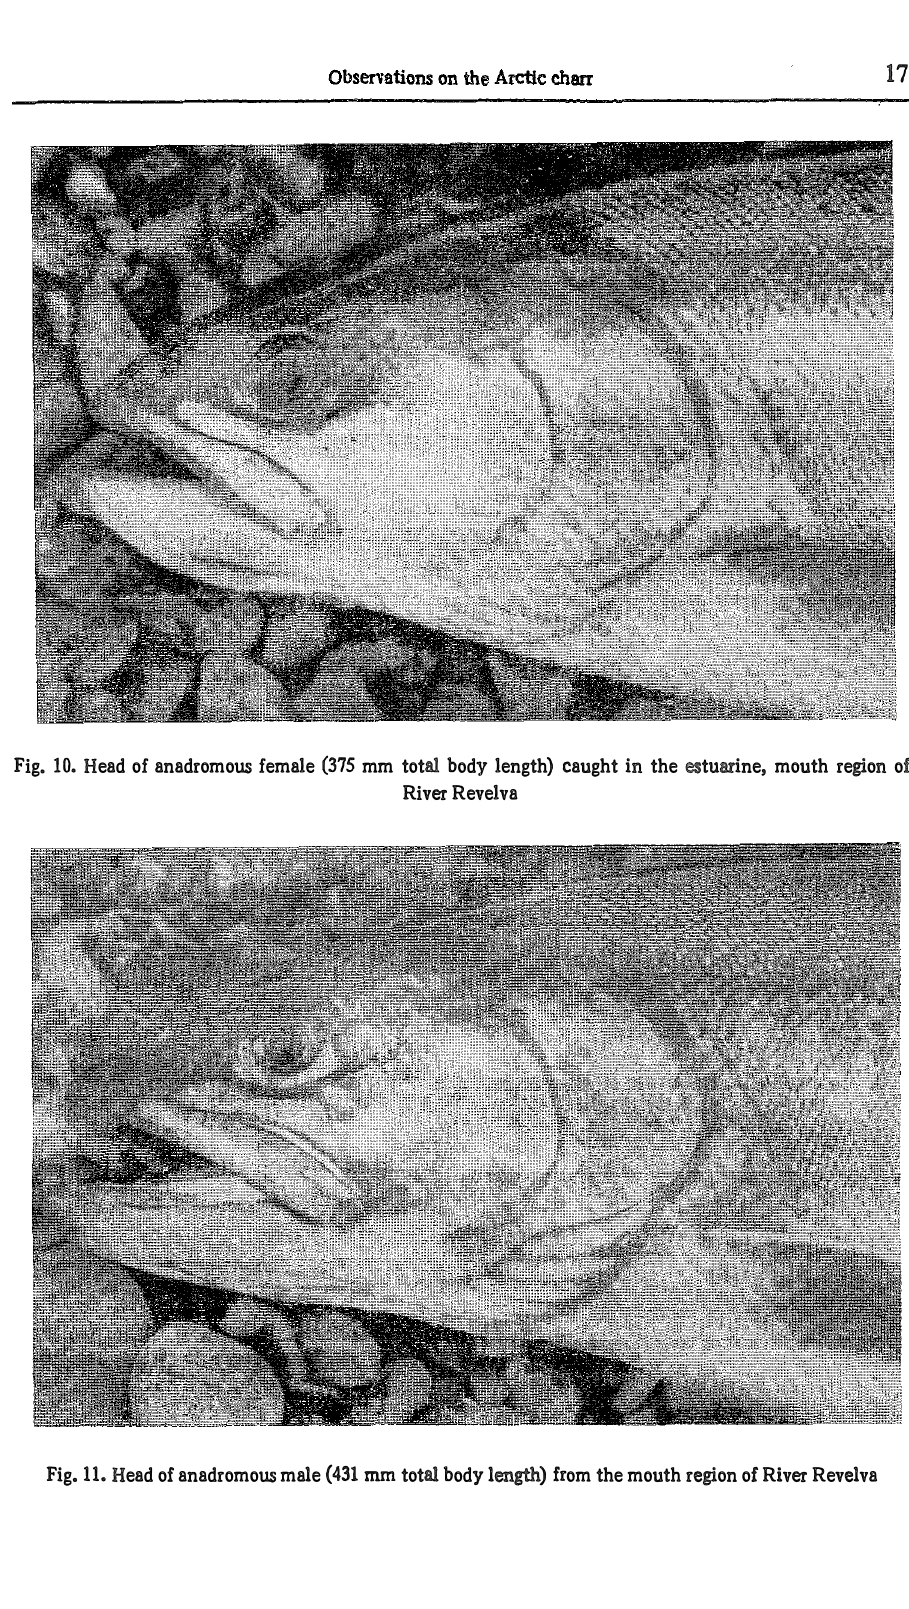
Fig, 11. Head of anadromous male (431 mm total body length) from the mouth region of River